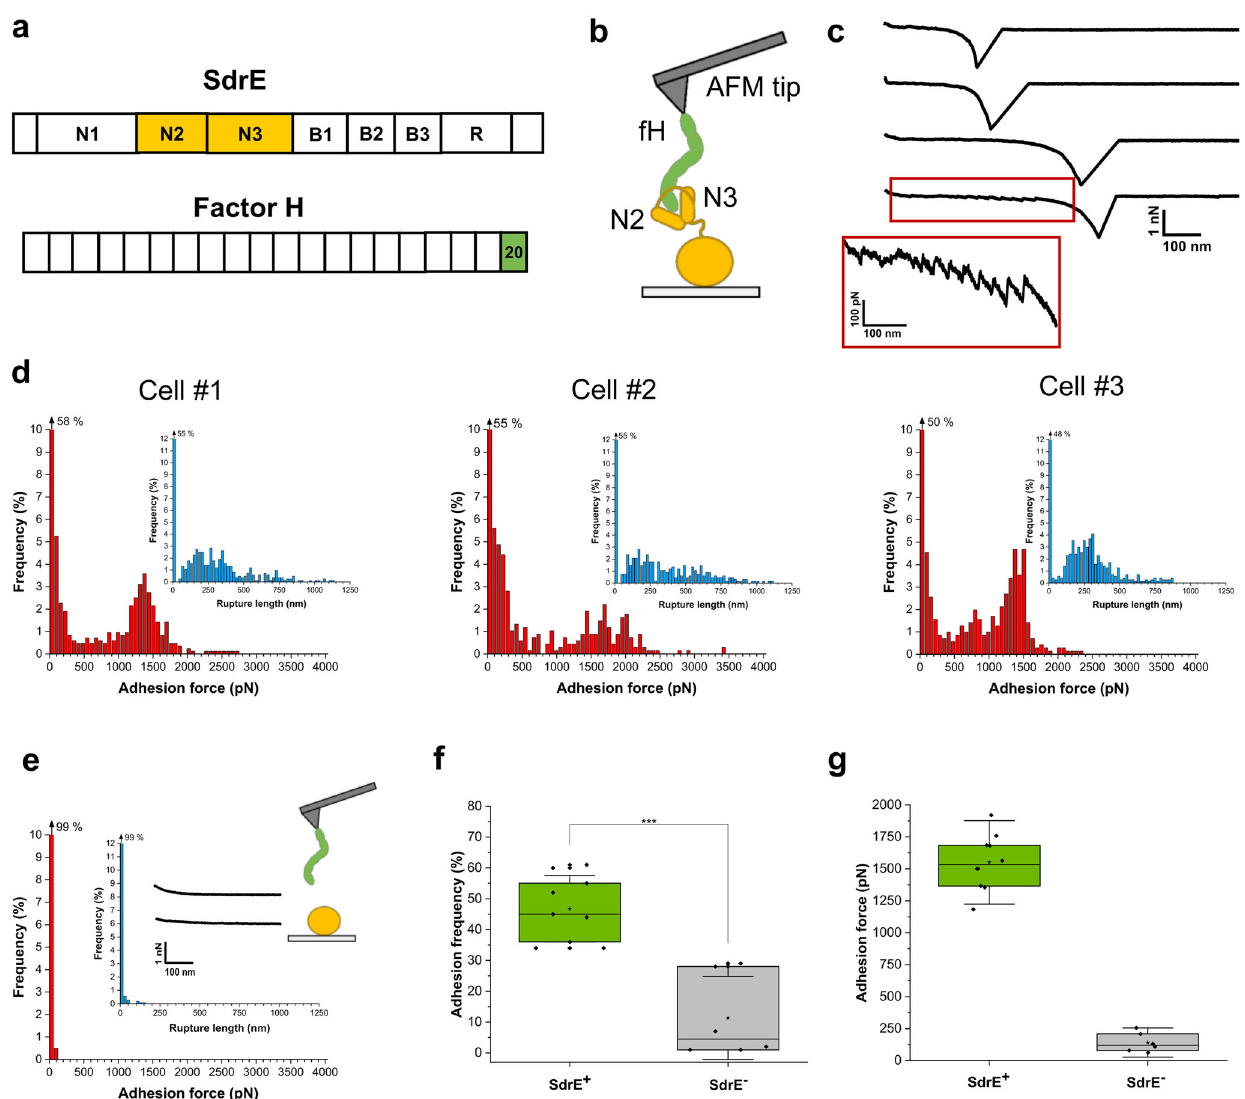
Fig. 1 Strength of single SdrE-fH bonds in living bacteria. a Schematic representation of the modular structures of SdrE and fH. In SdrE, N1-N3 is the ligand-binding region, B1-B3 the B repeats region and R the serine-aspartate repeat region. The 20 structural units of fH are the CCP (complement-control protein) repeats which are made of β -barrel folds. Here, we used a recombinant fH (amino-acids 860-1231) comprising the 6 terminal CCP modules (CCP15-20). The SdrE N2N3 domains bind a short peptide sequence from fH CCP20, the last fH structural unit. b Single-molecule force spectroscopy (SMFS) set-up used in this study. c Representative retraction force pro fi les obtained by recording force-distance curves in PBS between SdrE ( + ) cells and AFM tips functionalized with fH, documenting either a single adhesion (or “ rupture ” ) peak (three upper curves) or a single adhesion peak preceded by an unfolding force pattern (lower curve). The curve in the lower red box shows an enlargement of the unfolding pattern. d Adhesion force and rupture length (insets) histograms generated for three different SdrE ( + ) cells ( n = 838, 678, and 706 curves for cell #1, cell #2, and cell #3, respectively). e Force data obtained in the same conditions for a SdrE ( − ) cell ( n = 1,024 curves). f Box plot comparing the adhesion frequency of SdrE ( + ) and SdrE ( − ) bacterial strains ( n = 9 and 6 cells, respectively). *** p -value ≤ 0.001, determined by a two-sample t -test in Origin. g Box plot of the adhesion force measured for SdrE ( + ) and SdrE ( − ) cells ( n = 9 and 6 cells, respectively). In both f and g , stars are the mean values, lines the medians, boxes indicate the 25 – 75% quartiles and the standard deviation (S.D.) is indicated by the